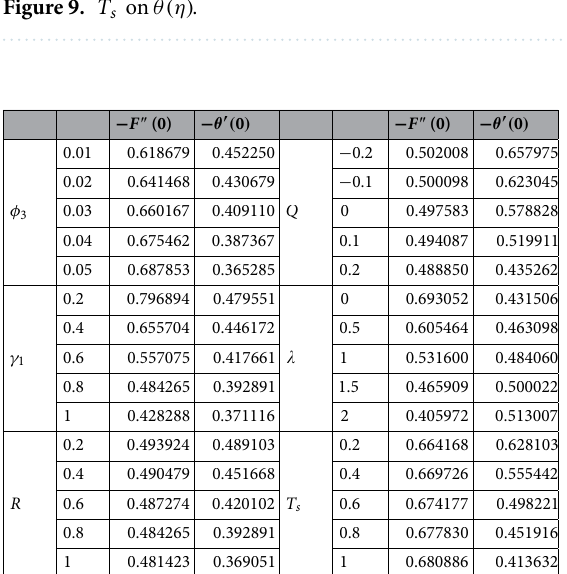
Table 3. Variations of